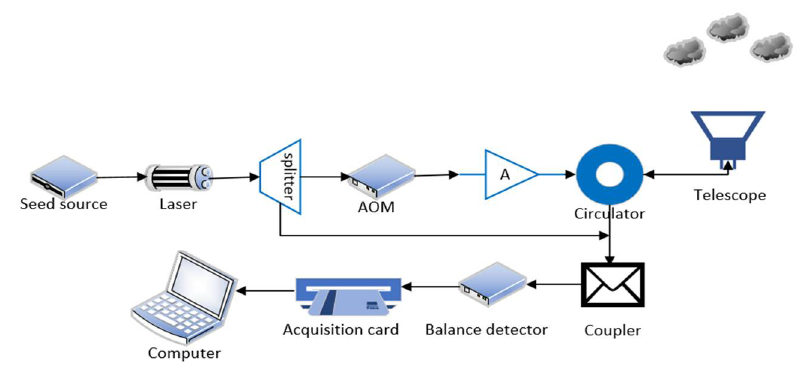
Figure 1. Wind profile Lidar system.